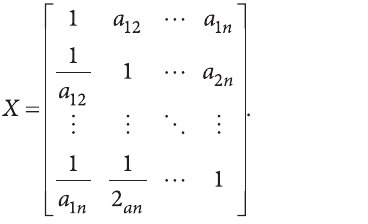
Table 3. Pairwise comparison reciprocal matrix estimates for 15 trunk road network sub-assets